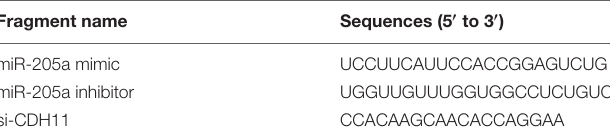
TABLE 2 | Oligonucleotide sequences in this